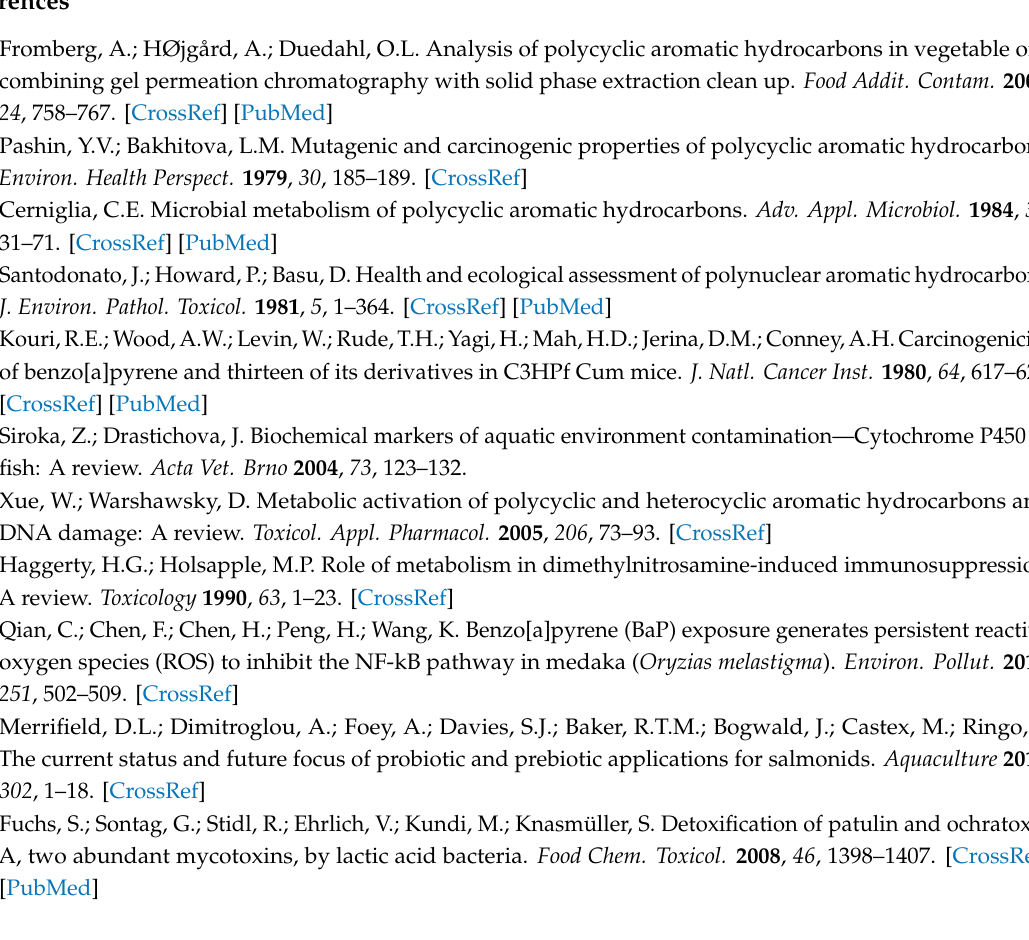
Table S1. GO classification of DEGs between Control and BI-04 (Cell Component); Table S2. GO classification of DEGs between Control and BI-04 (Biological Process), Table S3. The up-regulated genes and down-regulated genes in cell components between Control and BI-04, Table S4. The up-regulated genes and down-regulated genes in biological process between Control and BI-04, Table S5. GO classification of DEGs between Control and BaP (cell component), Table S6. GO classification of DEGs between Control and BaP (Molecar Function), Table S7. GO classification of DEGs between Control and BaP (Biological Process), Table S8. The up-regulated genes and down-regulated genes in cell components between Control and BaP, Table S9. The up-regulated genes and down-regulated genes in molecular function between Control and BaP, Table S10. The up-regulated genes and down-regulated genes in biological process between Control and BaP, Table S11. GO classification of DEGs between BaP and BI-04 + BaP (Cell Component), Table S12. GO classification of DEGs between BaP and BI-04 + BaP (Molecular Function), Table S13. GO classification of DEGs between BaP and BI-04 + BaP (Biological Process), Table S14. The up-regulated genes and down-regulated genes in cell components between BaP and BI-04 + BaP, Table S15. The up-regulated genes and down-regulated genes in molecular function between BaP and BI-04 + BaP, Table S16. The up-regulated genes and down-regulated genes in biological process between BaP and BI-04 +